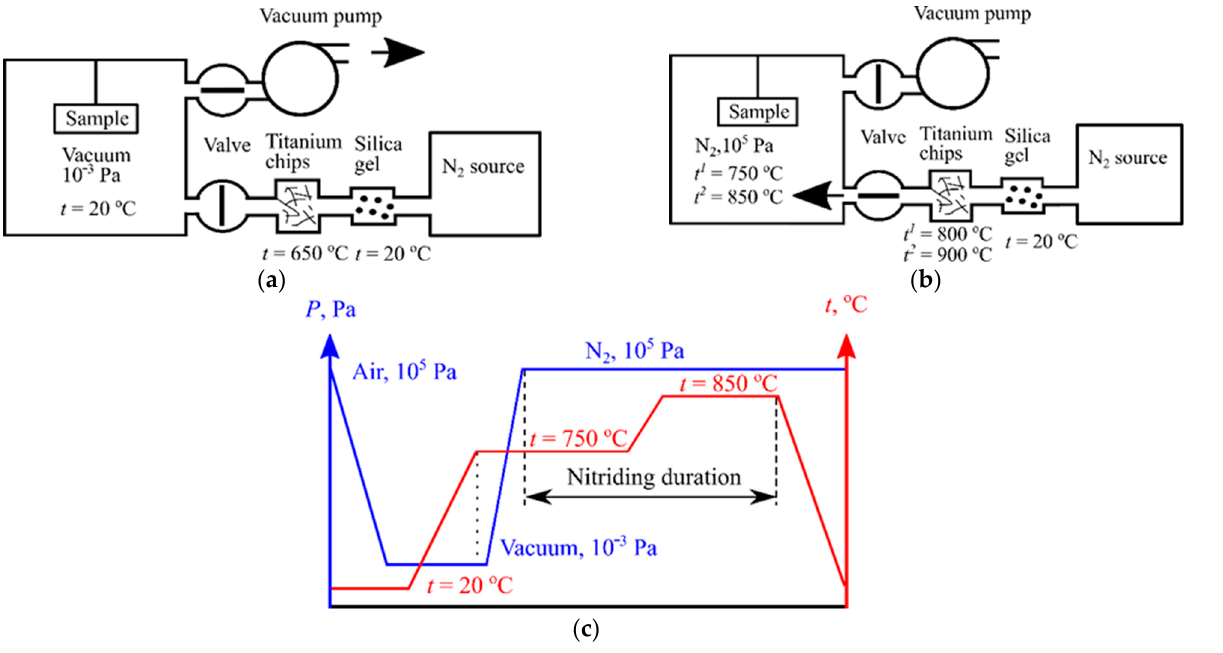
Figure 2. Titanium BT22 nitriding procedure: ( a )—furnace is prepared for thermochemical pro- cessing; ( b )—double-step nitriding process, ( c )—temperature and pressure graphs during the heat treatment procedure.